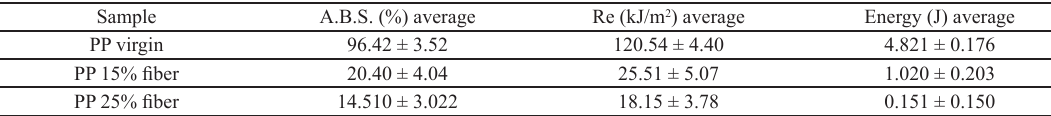
Table 6. Impact resistance results, unnotched specimens.